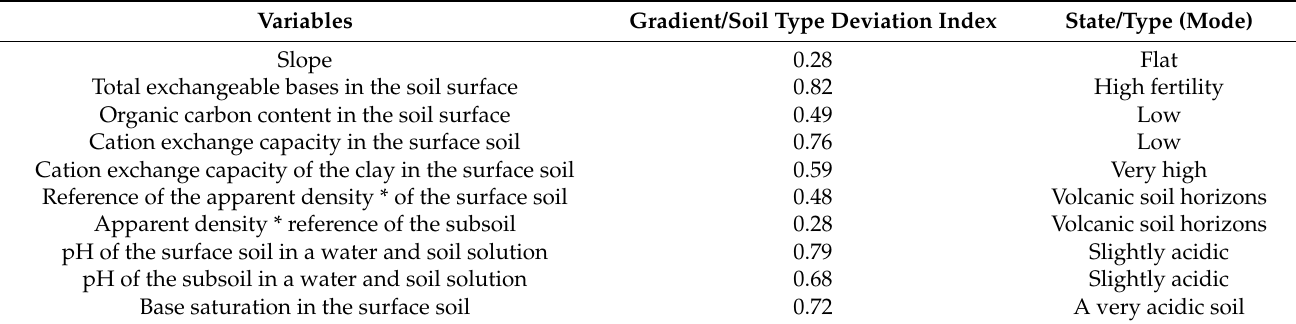
Table 4. Ecogeographic variability with qualitative characteristics in the cassava collection from